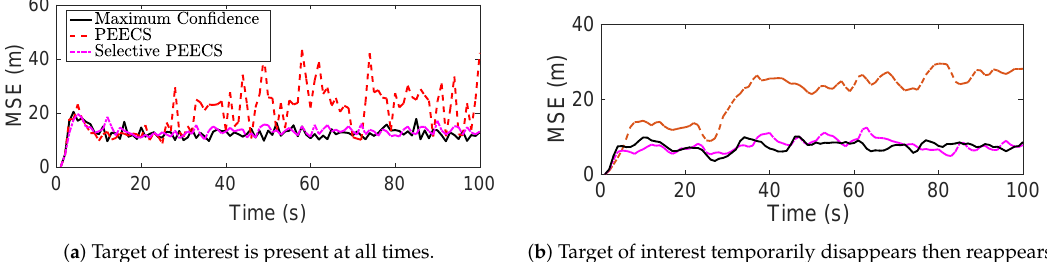
Figure 13. Mean square error of state estimates returned by selective sensor control methods (selective-PEECS and Maximum Confidence method) and non-selective PEECS as reported in